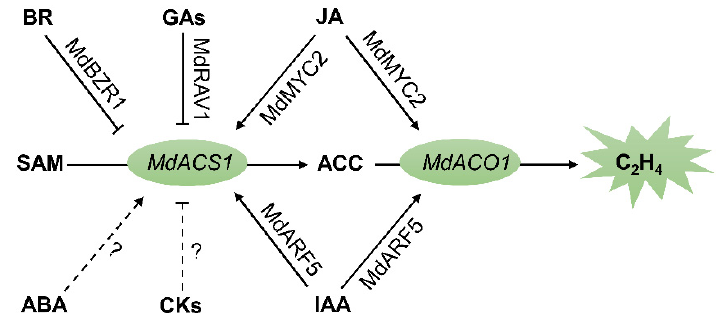
Figure 2. Phytohormone involved in regulating apple fruit ripening. → , promotion; ⊥ , suppression; solid arrow, clear regulation mechanism; dotted arrow, unclear regulation mechanism; SAM, S - adenosyl methionine; ACC, 1-aminocyclopropane-1-carboxylic acid; C 2 H 4 ; ethylene.